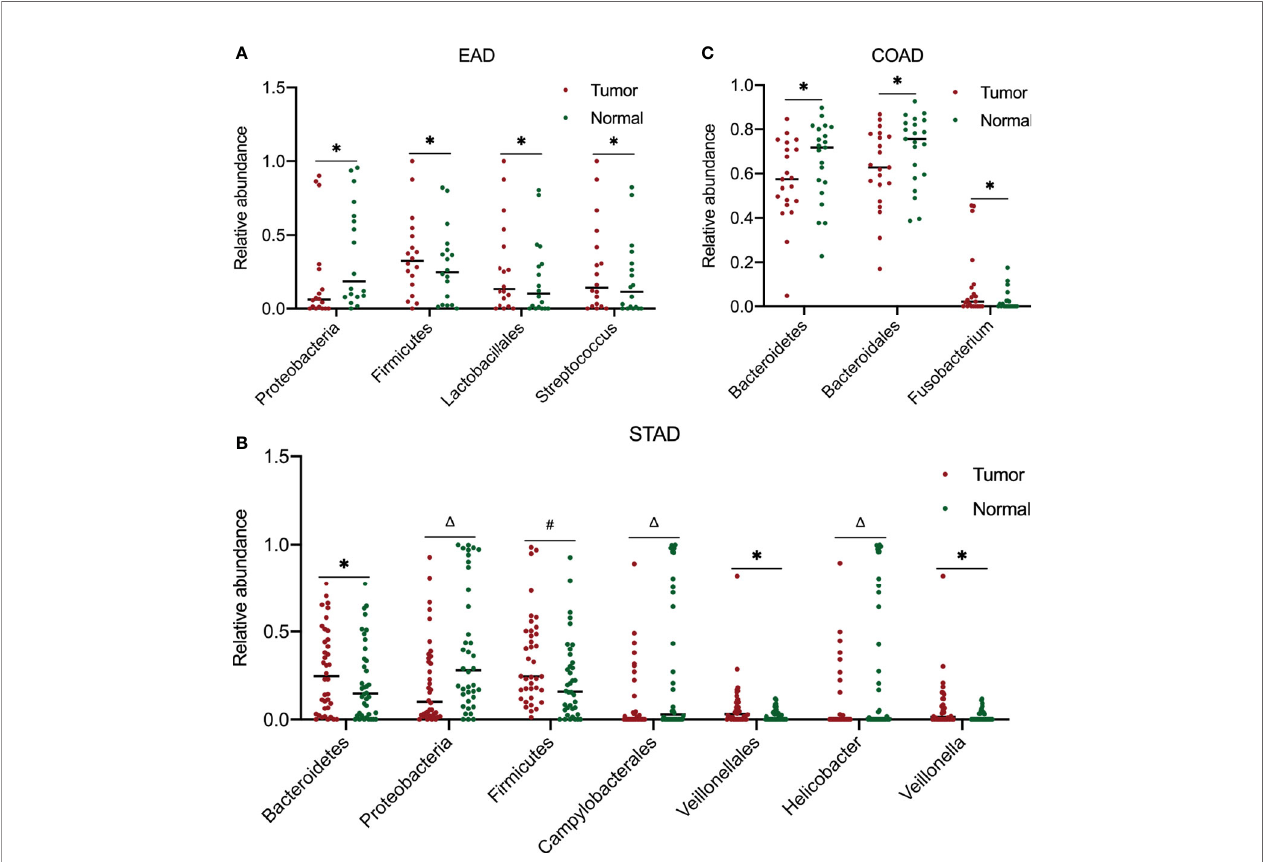
FIGURE 4 | Analysis of microbiota abundance differences between tumor and paired normal samples. In EAD (A) , STAD (B) , and COAD (C) , there were 18, 38, and 21 paired tumor-normal samples, respectively. For signi fi cance analysis, a paired two-tailed Student ’ s t-test was used. * P < 0.05, # P < 0.01, D P < 0.001 compared to the normal group. The differences between tumor and paired normal samples were not signi fi cant in ESCC and READ samples (data not shown). EAD, esophageal adenocarcinoma; ESCC, esophageal squamous cell carcinoma; STAD, stomach adenocarcinoma; COAD, colon adenocarcinoma; READ, rectum